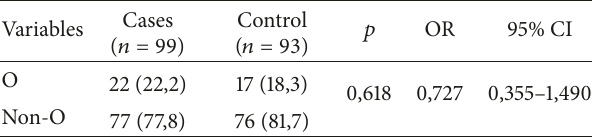
Table 3: Association between ABO gene polymorphism − 33G > A and acute myocardial infarct based on blood groups O and non-O.